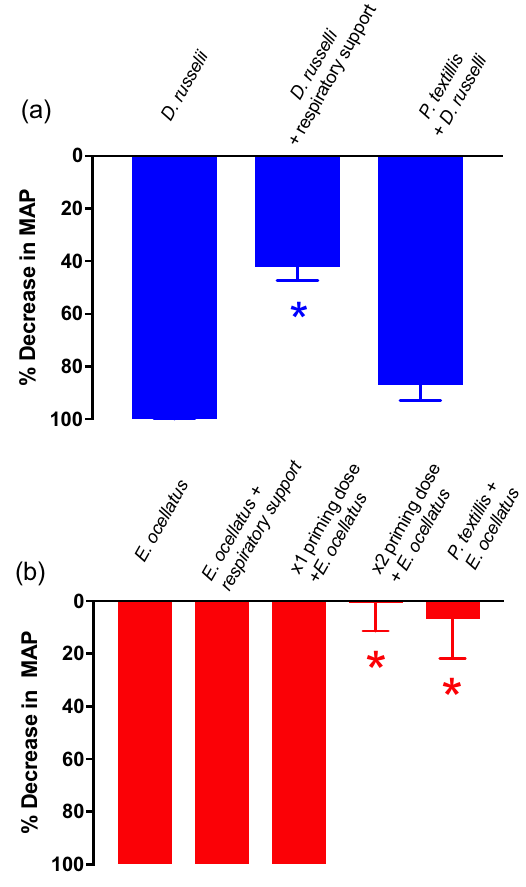
Figure 2. ( a ) The effects of D. russelii (1 mg/kg, i.v.) venom on the mean arterial blood pressure (MAP) of anesthetised rats in the presence (n = 5) or absence (n = 4) of artificial respiration, and in the presence of prior ‘priming’ with P. textilis venom (2 µ g/kg, i.v., n = 6). ( b ) The effects of E. ocellatus (50 µ g/kg, i.v.) venom on MAP of anesthetised rats in the presence (n = 5) or absence (n = 4) of artificial respiration, and in the presence of prior ‘priming’ with either P. textilis venom (2 µ g/kg, i.v., n = 5), or one or two sequential doses of E. ocellatus venom (1 µ g/kg, i.v., n = 3–4) venom. * P < 0.05 significantly different from response to same venom alone.